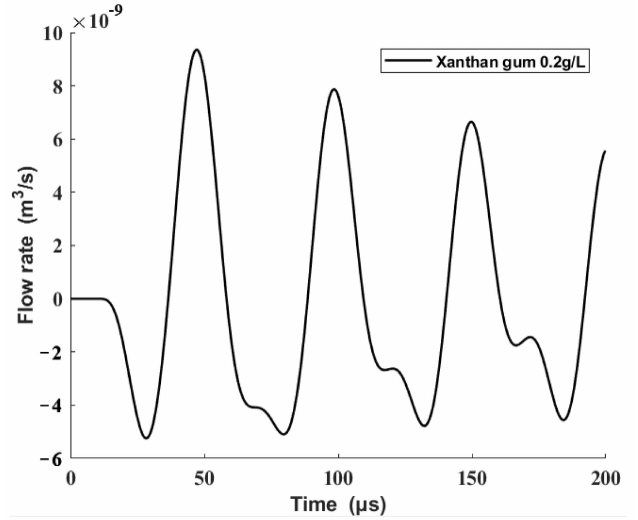
Figure 9. Result of the modified model.